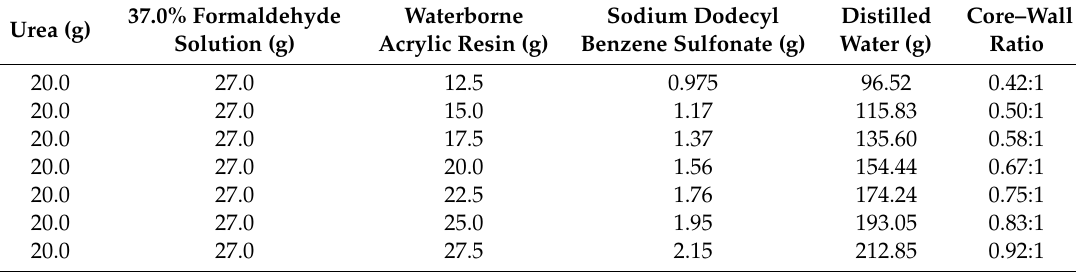
Table 1. Detailed List of Each Substance Dosage for the Preparation of